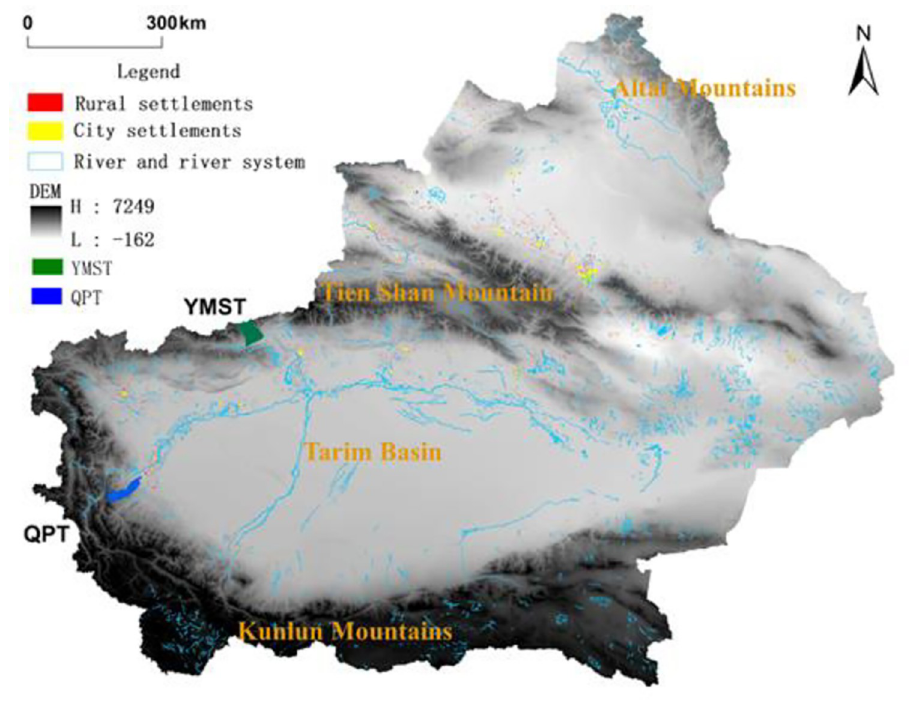
Fig 1. Geographic location of the study area. (The original map was downloaded from The Gateway to Astronaut Photography of Earth Website (https://eol.jsc.nasa.gov/SearchPhotos/). The map downloaded from this website is free and open to scholars; thus, we do not need to supply copyright permission).